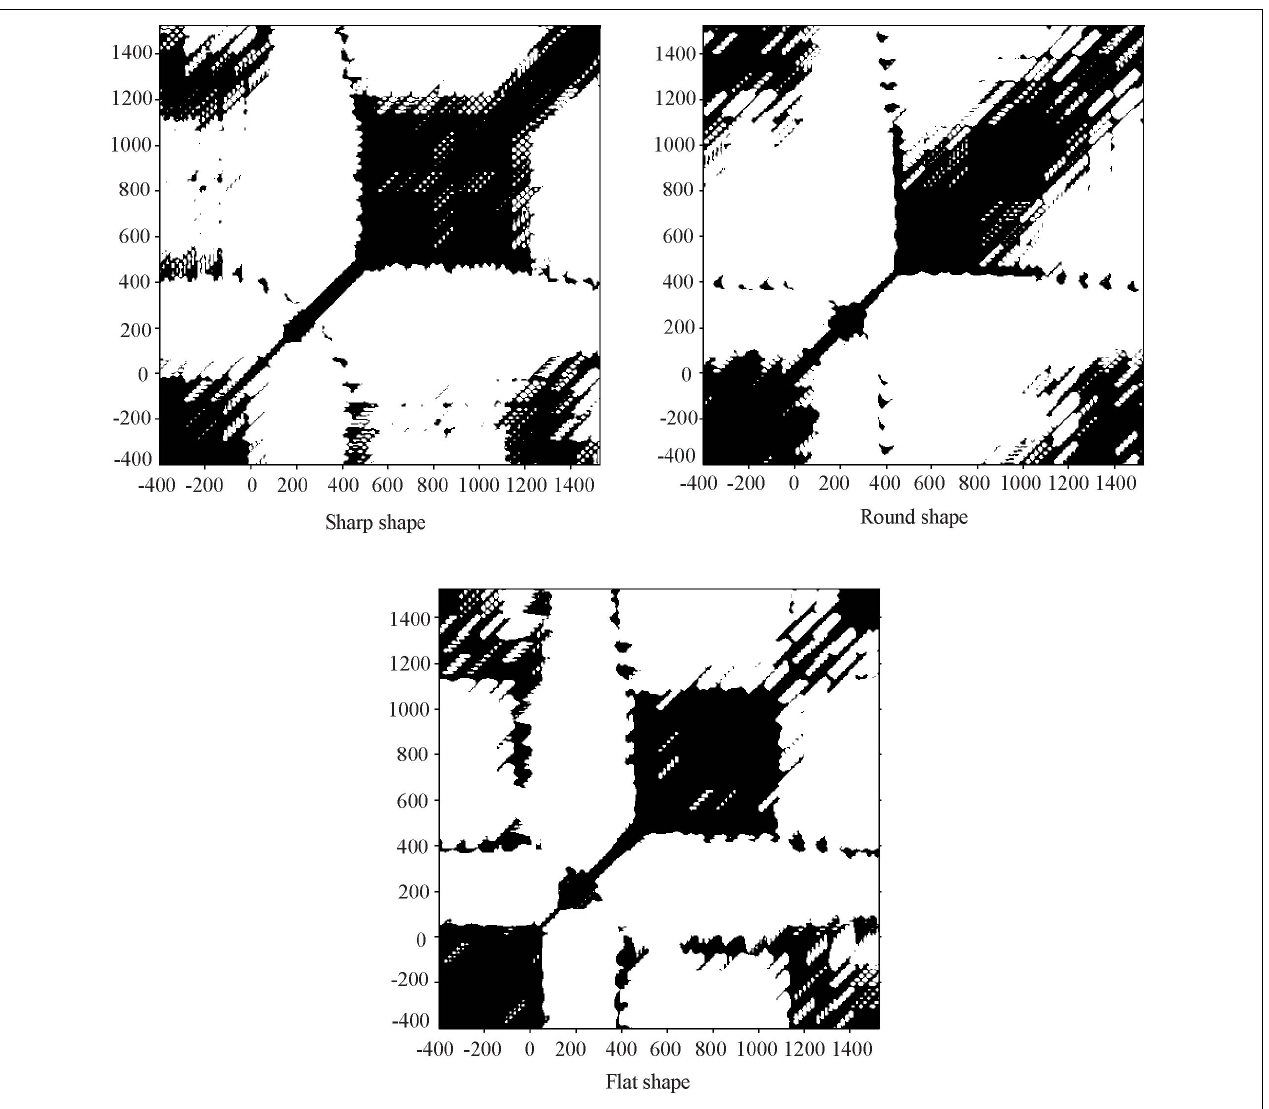
FIGURE 6 | Recurrence plots of ERP signals stimulated by three